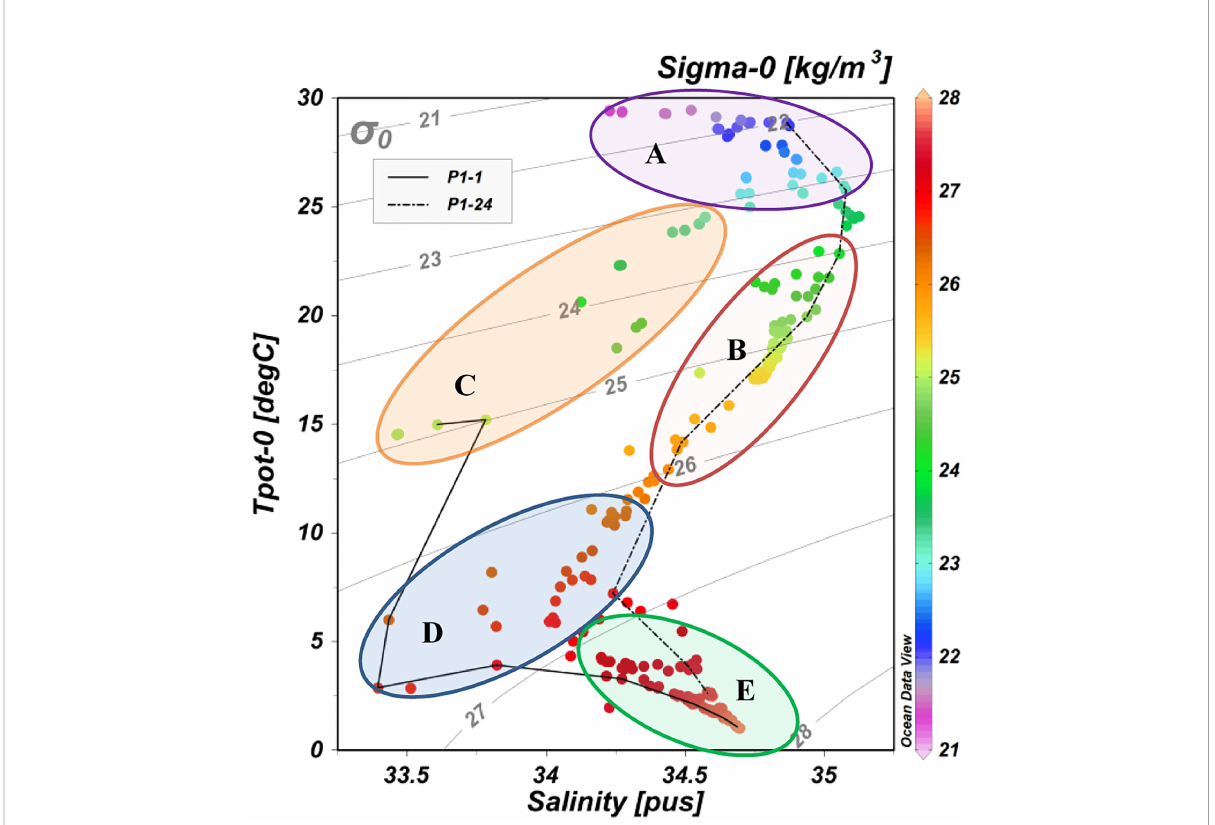
FIGURE 2 Plots of water temperature versus salinity with density (Sigma-0) associated with different water masses (represented by different colored points) along the P1 transect in the western NP in November 2019 using ODV. The color bar on the right side indicates the potential density. The solid line represents Station P1-1 in the KE region. The dotted line represents Station P1-24. The A-E regions represent low-density and high- temperature water in the upper 200 m depth (A) and the mixed water in the upper 200 – 300 m depth (B) at low latitudes (13°N – 30°N), the denser and colder water in the upper water of the KE region [(36°N – 40°N, (C) ], the NPIW water mass (D) , and deep water below a 1,000 m depth (E) along the P1 transect in the western